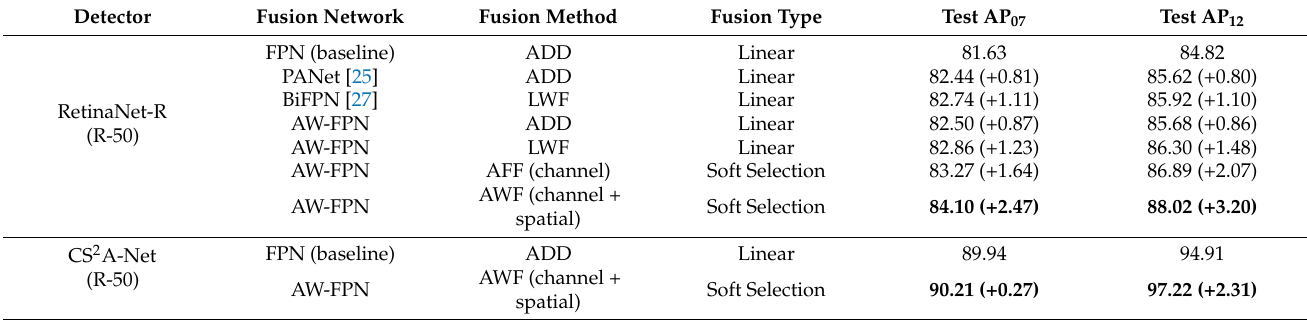
Table 9. Comparison of different feature fusion networks on